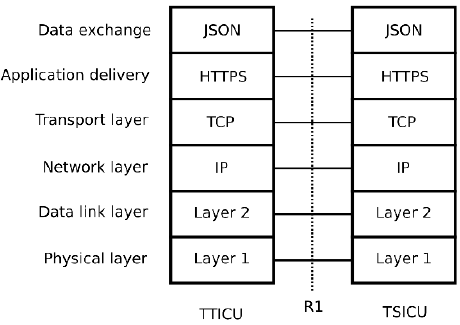
Figure 5. Protocol stack of the R1 interface.